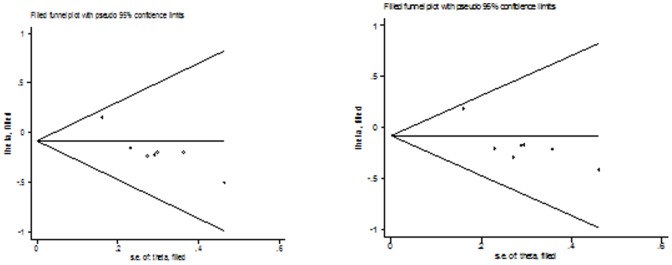
The Duval and Tweedie nonparametric “trim and fill” method's funnel plot funnel plot of the meta-analysis of colorectal cancer risk and CYP1B1 Asn453Ser polymorphism (additive model and dominant model).